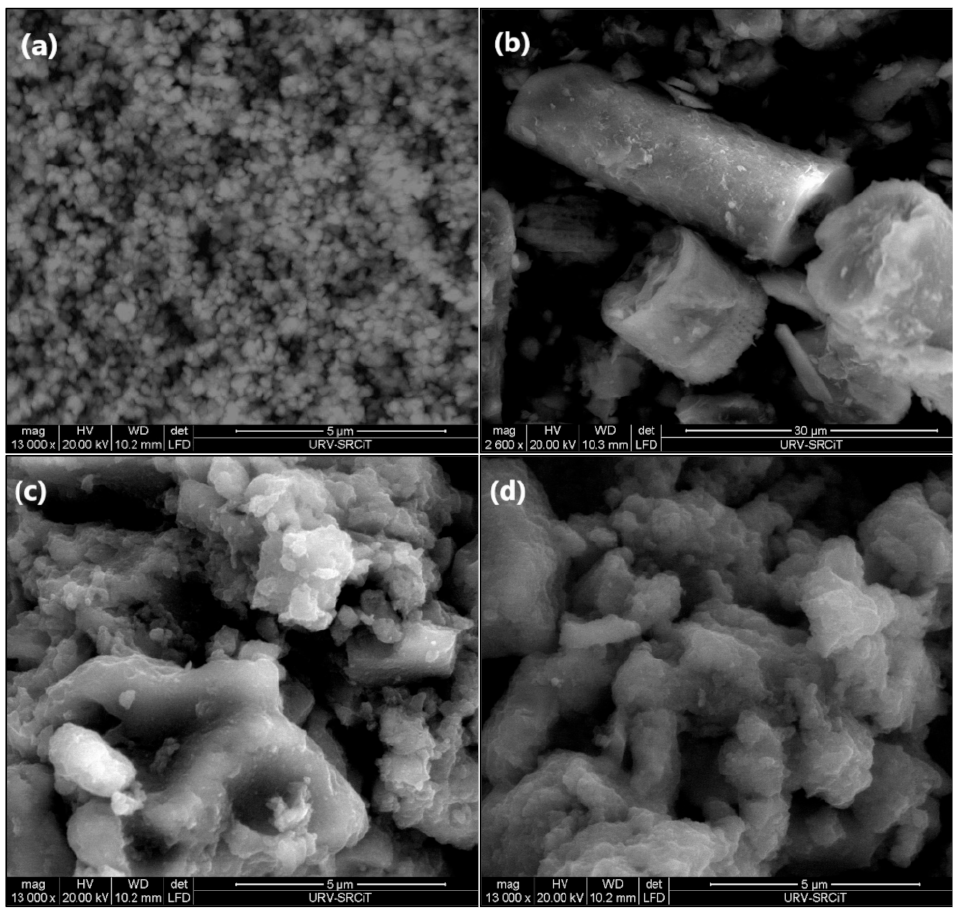
Figure 4. Scanning electron microscopy (SEM) images of ( a ) ZnTiO 3 /TiO 2 /La (ZTO/La), ( b ) di- atomaceous earth (DE), ( c ) ZnTiO 3 /TiO 2 -DE (ZTO-DE), and ( d ) ZnTiO 3 /TiO 2 /La-DE